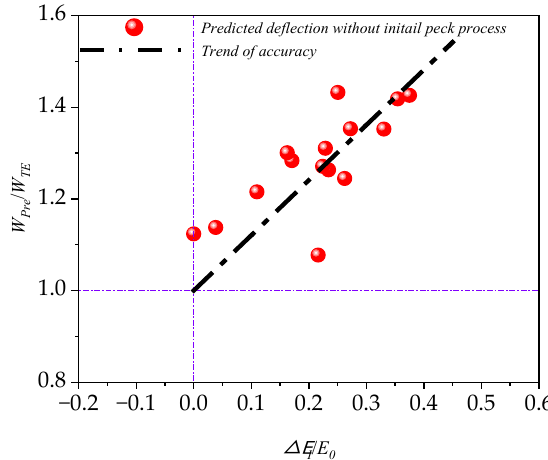
Figure 6. Accuracy without the initial peak stage (IPS).